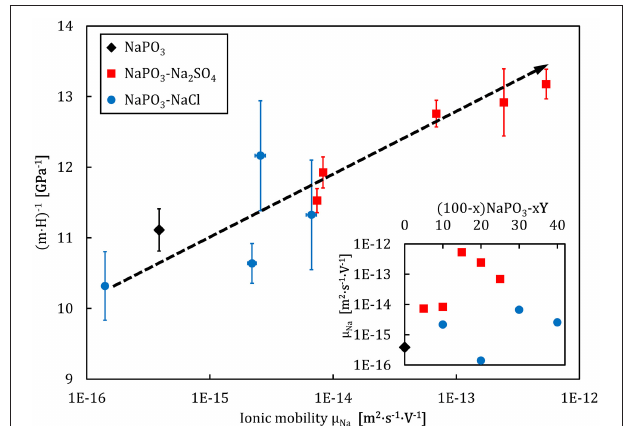
FIGURE 14 | Flow event volume, gauged by ( m · H ) − 1 , as a function of the logarithm of ionic mobility (at T = 323K) for the NaPO 3 -NaCl-Na 2 SO 4 glass system. The dashed line is a guide to the eye. The inset shows the compositional dependence of the ionic mobility.